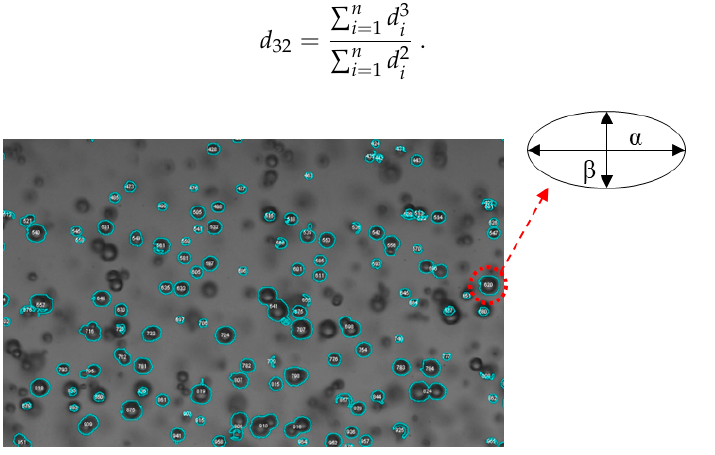
Figure 5. Sample of processed bubble-image using ImageJ for bubble size measurements.